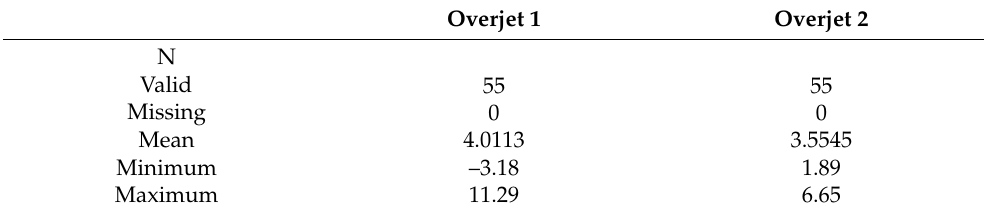
Table 3. Comparison between initial and final overjet of t Group